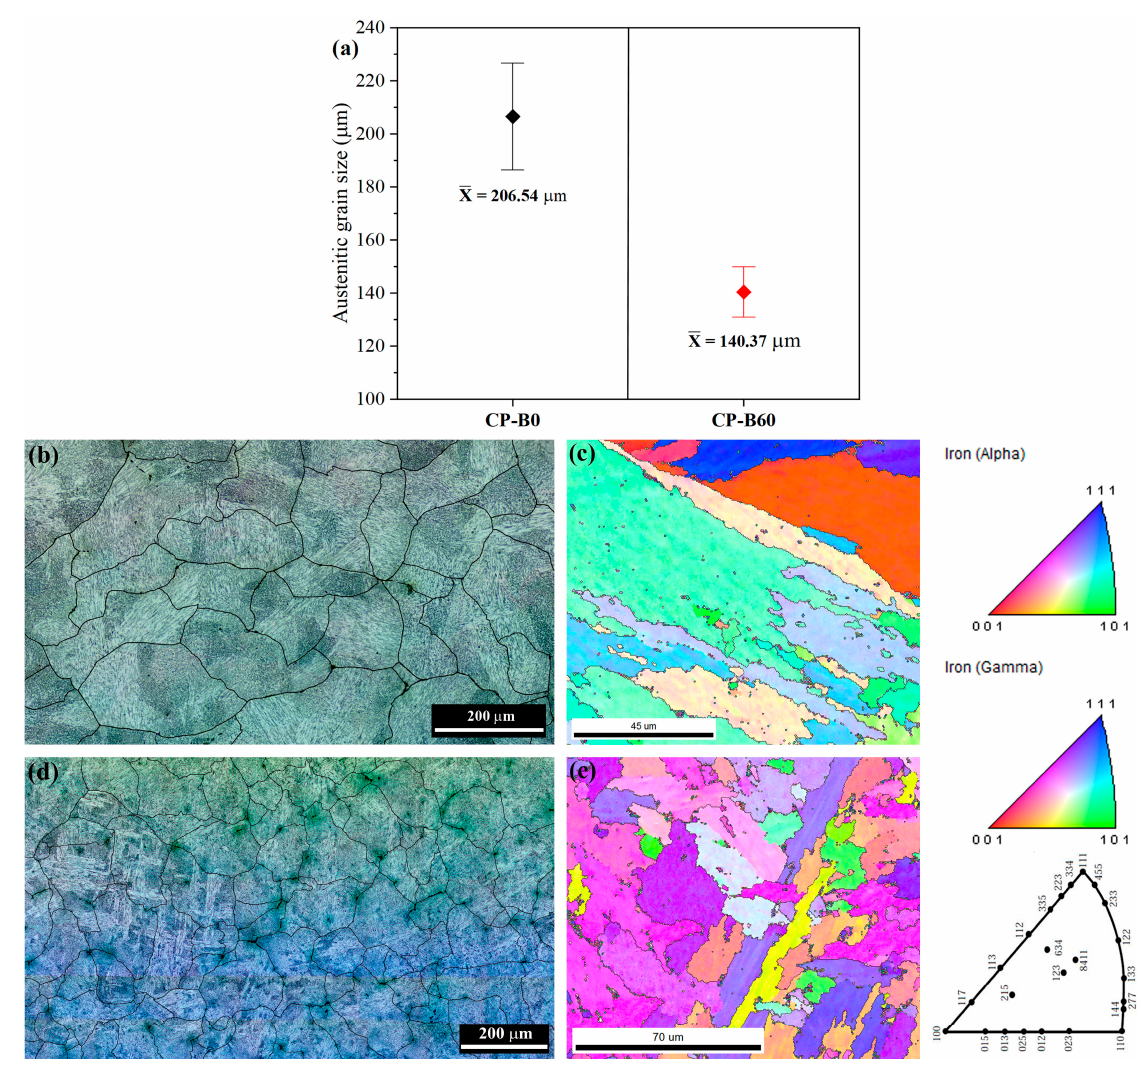
Figure 5. Solidification microstructure of the complex phase (CP) steel: ( a ) average profile of the austenitic grain size for boron-free (CP-B0) and boron-containing (CP-B60) steels, ( b , d ) optical mi- crographs of CP-B0 and CP-B60 steels, and ( c , e ) SEM-EBSD IPF images of CP-B0 and CP-B60 steels.